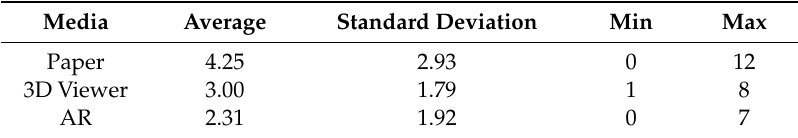
Table 6. The ANOVA result of assembly errors.